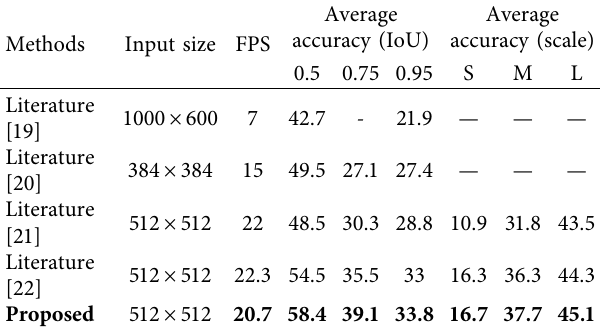
Table 2: Experimental results of MS COCO dataset (bold is the best result).